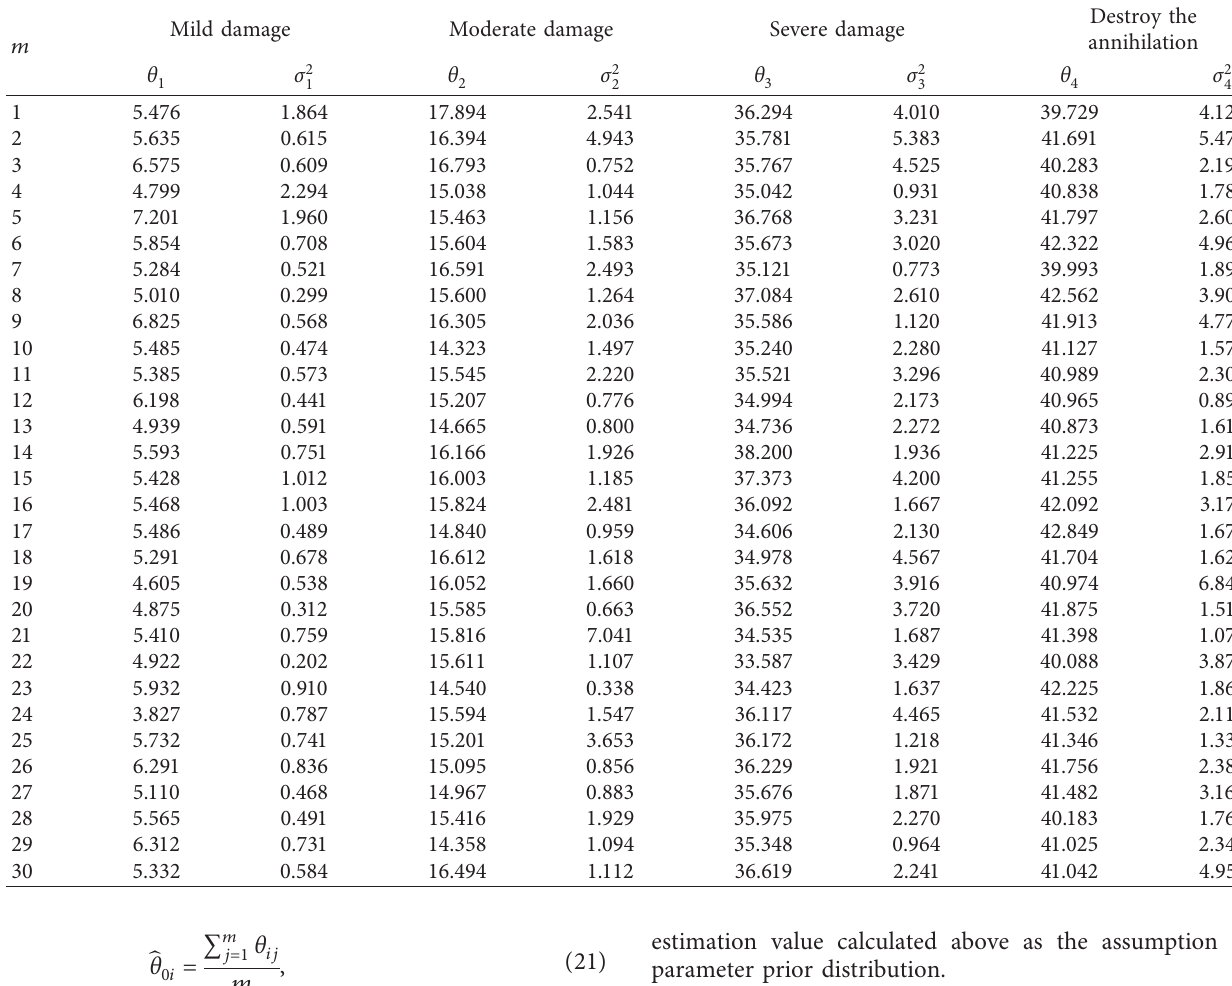
Table 2: Parameter sample data formed by prior